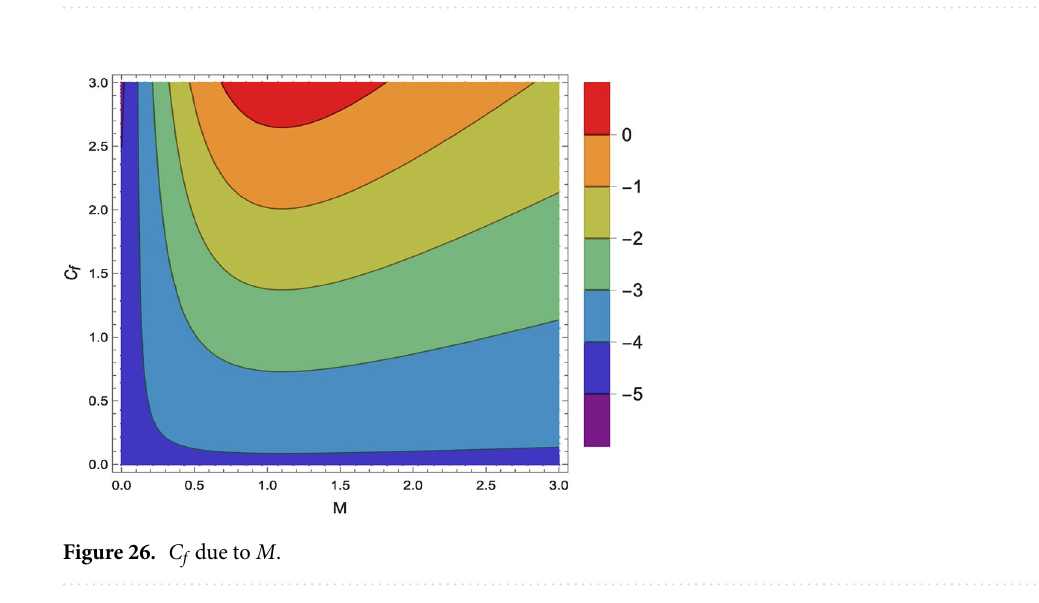
Figure 25. Change in gyrotactic microorganism profile due to Pe when Fr = 0.2, k 1 = 0.1, k 2 = 0.3, M = 0.5, m = 0.2, Pr = 5.3, φ = 0.01, Ec = 0.3, ε t = 3.0, Rd = 0.2, Sc = 0.1, ε C = 3.0, δ = 0.3, Lb = 0.3.